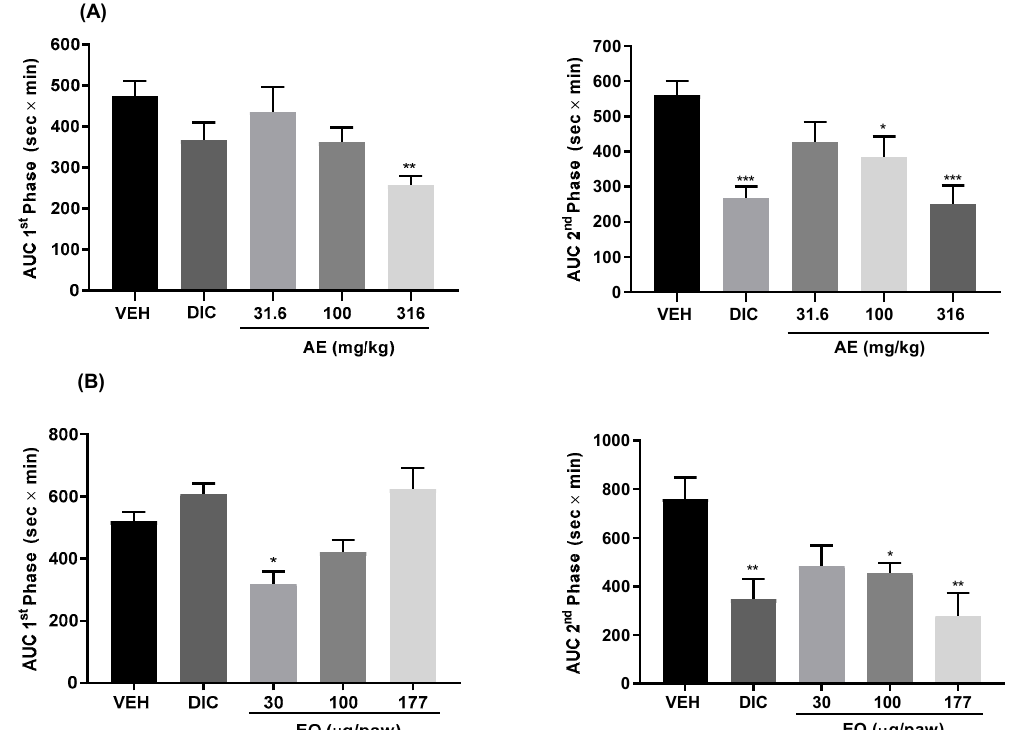
Figure 1. Antinociceptive effect of an aqueous extract (31.6 − 316 mg/kg) and an essential oil (30 − 177 µ g/paw) from B. heterophylla in the formalin test in mice. ( A ) AUC from the time course curve of phase 1 and AUC from the time course curve of phase 2. VEH: vehicle (0.9% saline solution). DIC (50 mg/kg, p.o.). ( B ) AUC from the time course curve of phase 1 and AUC from the time course curve of phase 2. VEH: vehicle (0.9% saline solution). DIC: (100 µ g/paw, i.pl.). Each measurement represents the mean ± SEM 6 mice per group. Significantly different from VEH group (* p < 0.05, ** p < 0.01, *** p < 0.001) determined by ANOVA followed by Dunnett’s post hoc test.